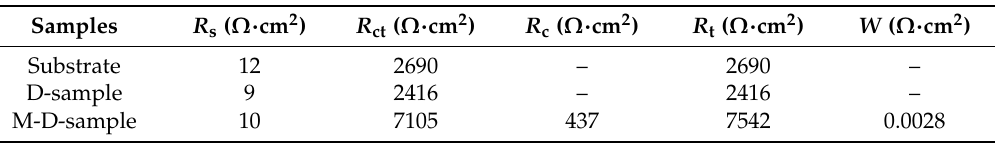
Figure 9. Equivalent circuit patterns of ( a ) Al alloy substrate, deposited sample (D-sample) and ( b ) modified deposited sample (M-D-sample). Table 2. Fitted electrochemical parameters of Al alloy substrate, deposited sample (D-sample), and modified deposited sample